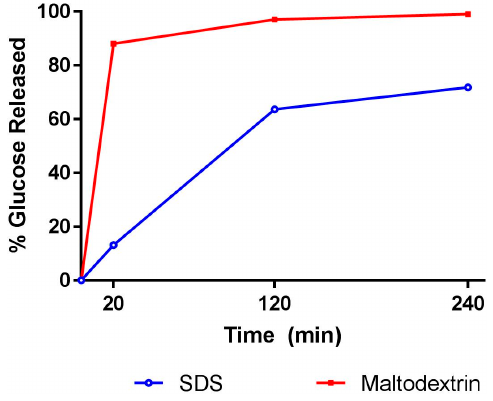
Figure 2. In Vitro digestibility profile of slowly digestible starch (SDS) and maltodextrin.